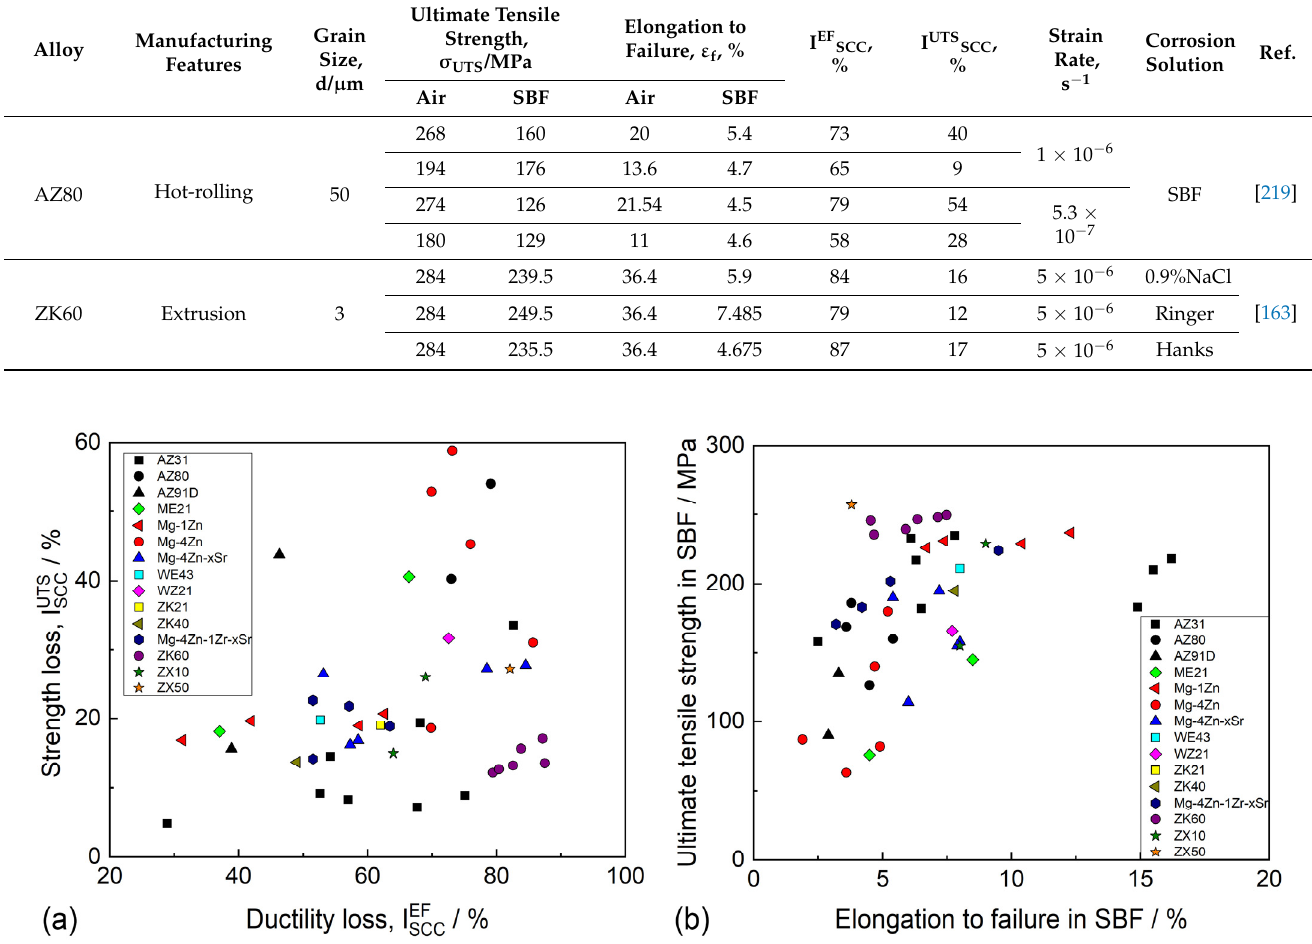
Figure 8. The relationships between the ductility and strength of the biodegradable Mg alloys SSRT- tested in SBFs in terms of SCC susceptibility indexes ( a ) and the absolute values of ultimate tensile strength and elongation to failure ( b ); data are imported from Table 5 and the references therein.